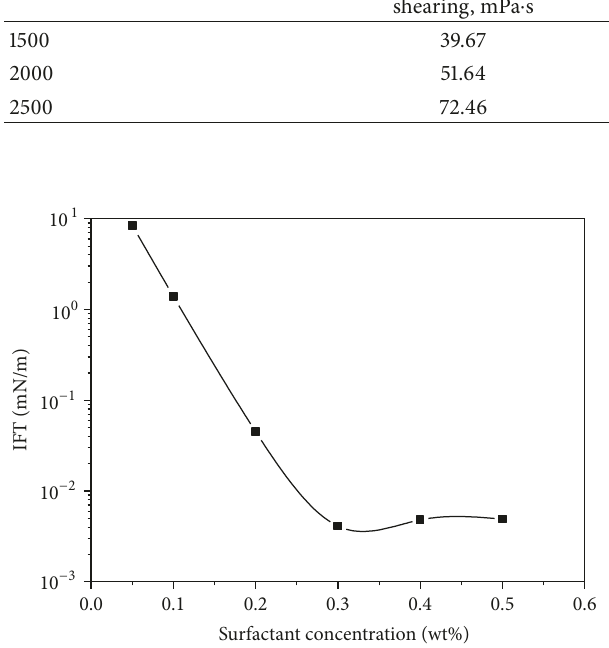
Figure 4: Relationship of TSI −1 and separated water ratio when surfactant concentration varies. The polymer concentration is 2000